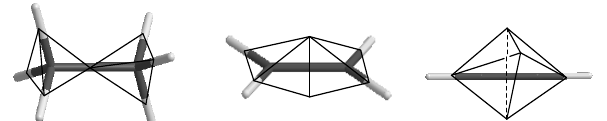
Figure 4. Single, double and triple bond in ethane, ethylene and acetylene respectively left to right.